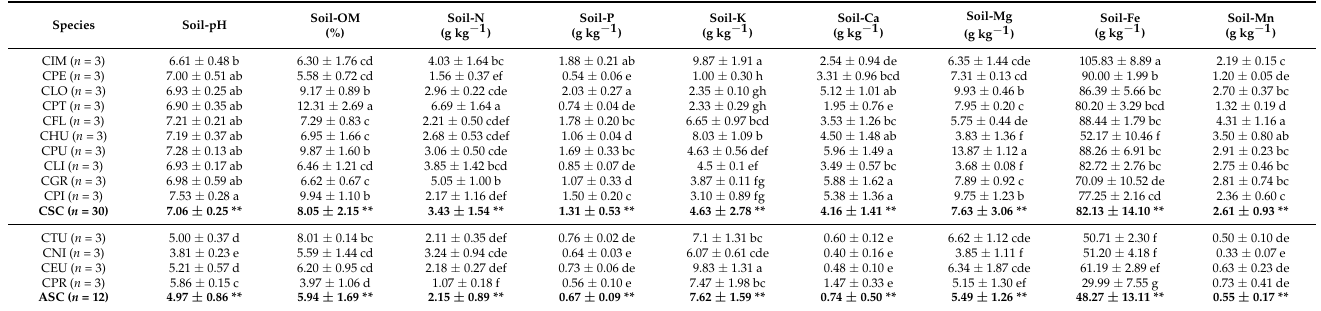
Table 1. The pH, organic matter (OM), and major nutrient contents of the habitat soils of golden Camellia